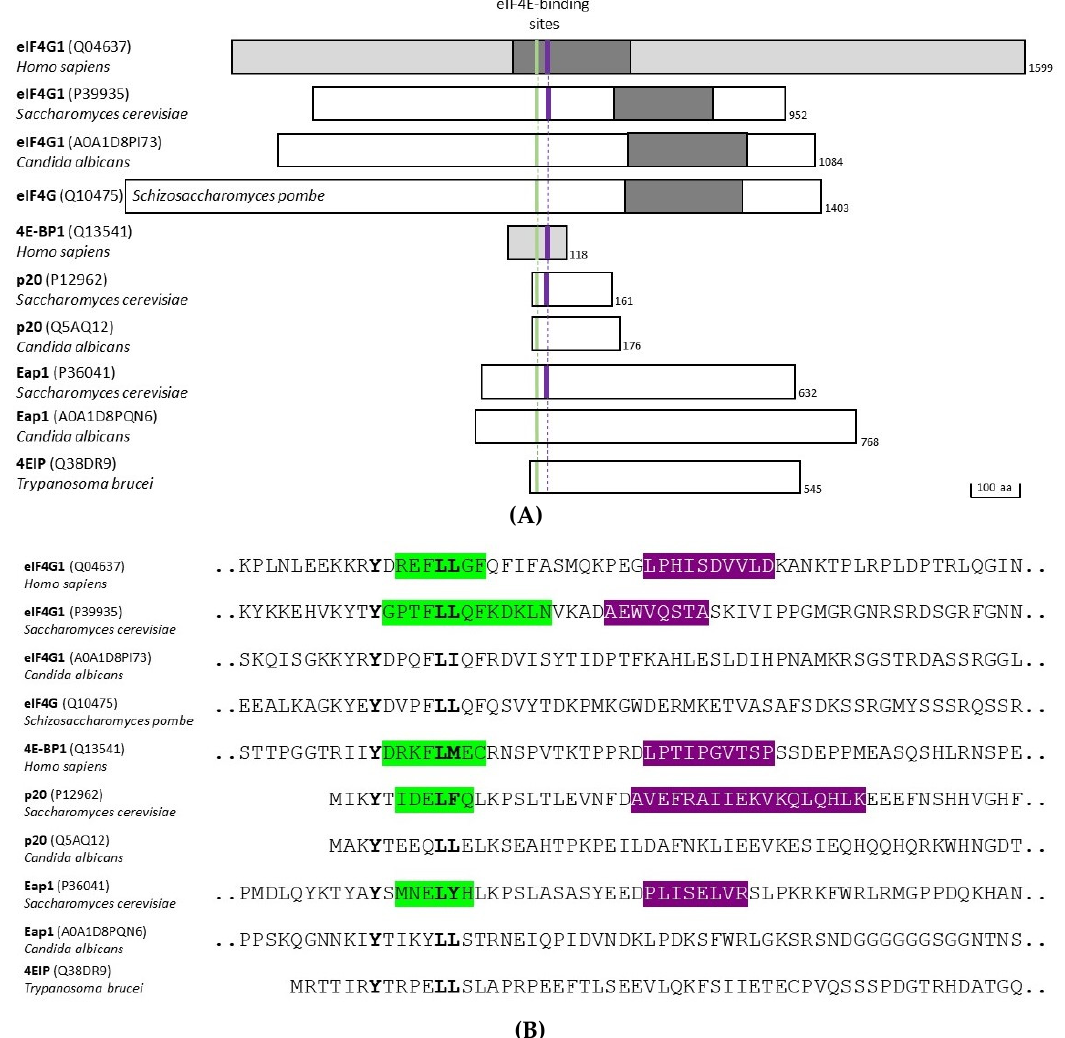
Figure 3. ( A ) Scheme representing eIF4G and other eIF4E-interacting proteins from different species (as indicated in the cartoon). All proteins are aligned according to their canonical (in green) and non-canonical (violet) eIF4E-binding sites that were shown directly by solving 3D structures of eIF4E in complex with the 4E-BPs (5T46, 6FC1, 4UED, 6FC3, 6FC2). HEAT/MIF-4G domains are displayed in dark grey. ( B ) Sequences of the canonical (green) and non-canonical eIF4E-binding (violet) amino acid motifs from different species aligned according to the canonical eIF4E-binding motif YxxxL Φ (bold).